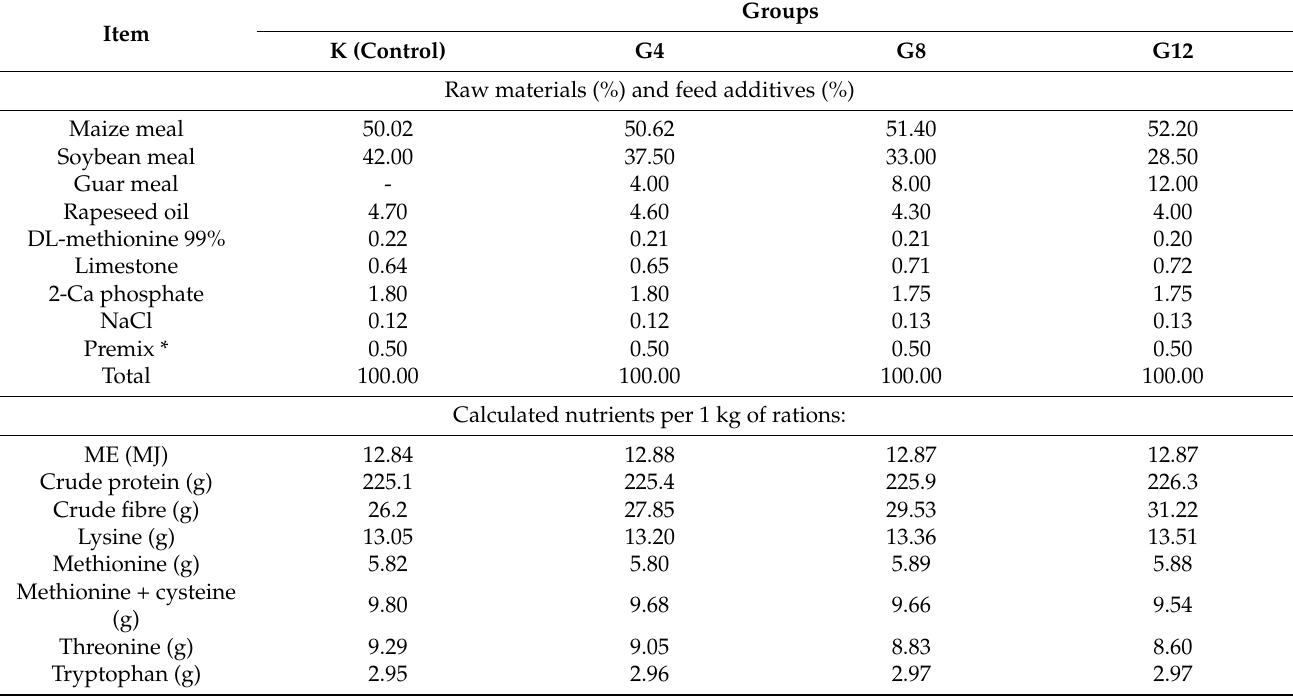
Table 1. Composition and nutritive value of starter rations containing graded levels of guar